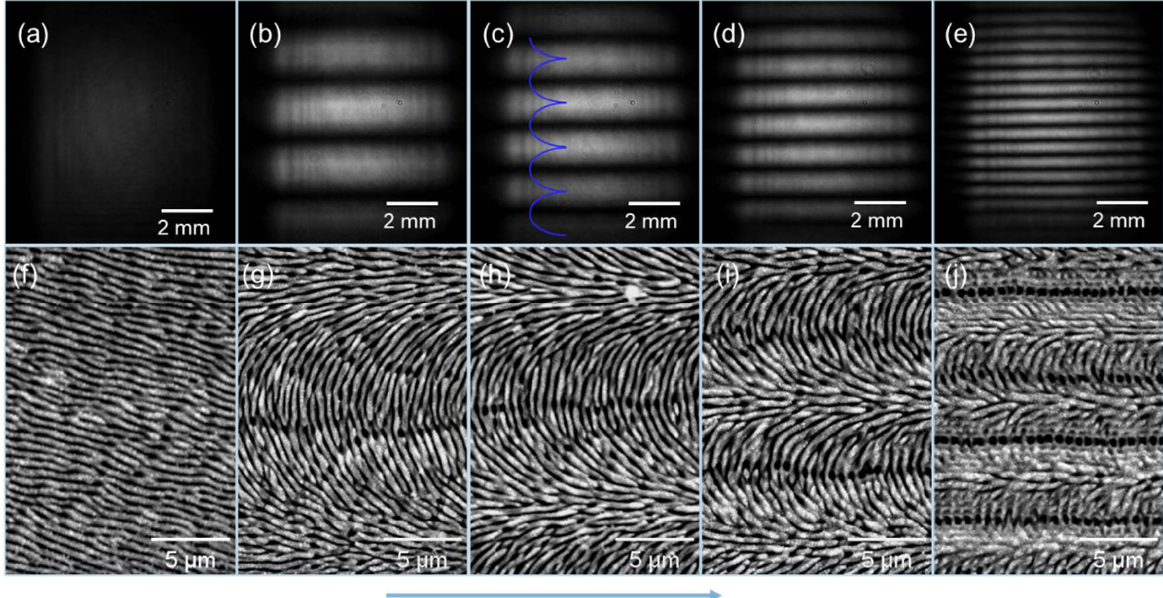
Figure 3. Nanostructures on the tungsten surface fabricated by femtosecond laser with different polarization distributions. During the fabrications, the target was moved along the x direction (see Figure 1). ( a – e ) Cross-sectional intensity distribution of the femtosecond laser recorded by the apparatus in the solid frame shown in Figure 1. The transmission axis of the linear polarizer (LP2) was along the x direction. For vector beams, the period of the polarization variation along the vertical ( y ) direction is presented in the uppermost row. The blue solid curve in ( b ) presents the polarization distribution of the vector beam. ( f – j ) Nanostructures fabricated on the tungsten target. The target scanning speed was 0.06 mm/s, and the single-pulse energy of the femtosecond laser striking on the target surface was 20 μJ.